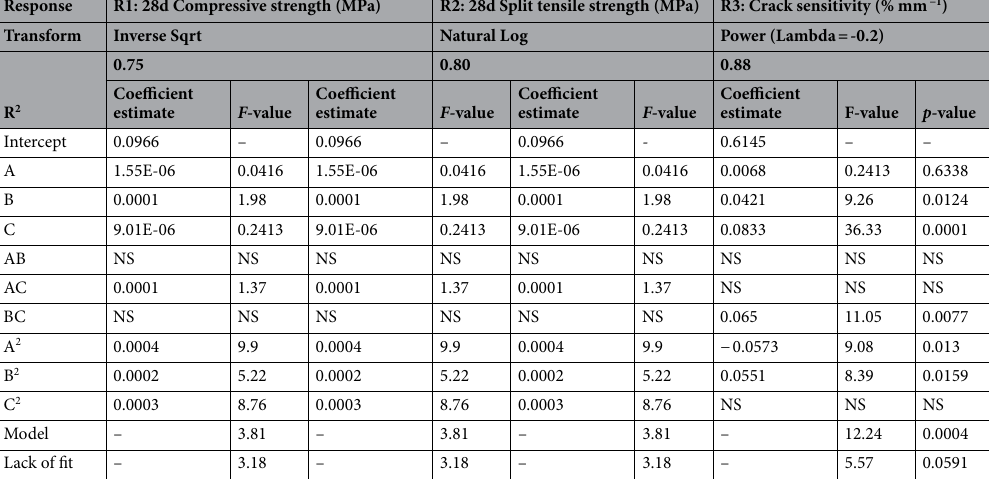
Table 5. Parameter estimation and variance analysis of the response surface model for bending performance and crack sensitivity. Where factor A is the silica fume/binder ratio, B is the fly ash/ binder ratio, C is the volume content of steel fiber. NS means that insignificant factors are